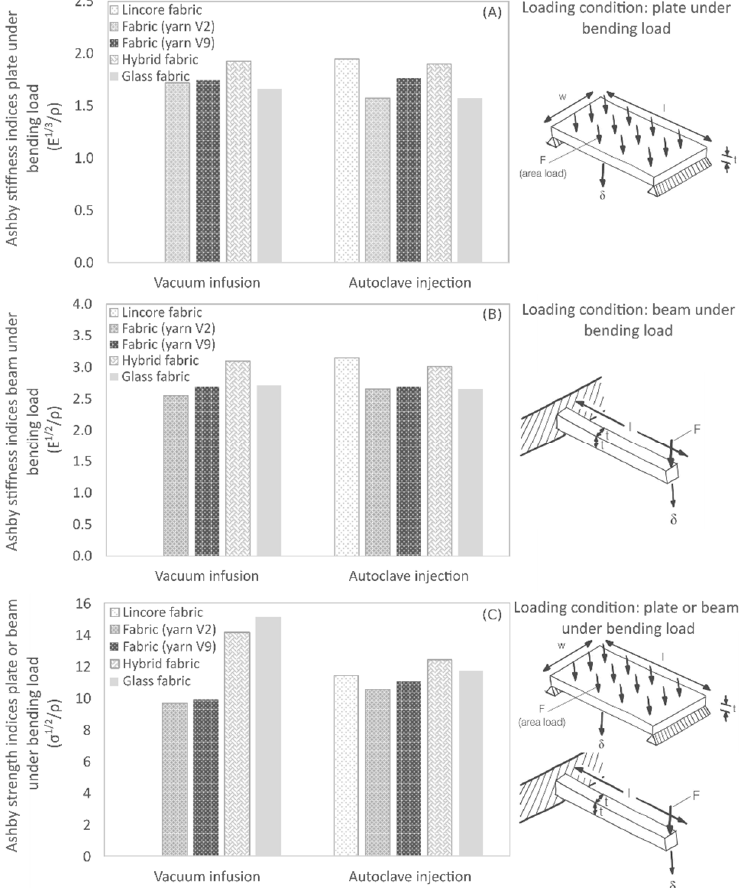
Figure 16. Ashby indices of composite materials produced by vacuum infusion and autoclave injection. The fibre orientation was taken into account in the longitudinal direction. ( A ) plate loaded in bending (stiffness-limited design at minimum mass; stiffness, length, width specified, thickness free), ( B ) beam loaded in bending (stiffness-limited design at minimum mass; stiffness, length, shape specified, section area free) and ( C ) plate loaded in bending (strength-limited design at minimum mass; plate: stiffness, length, width specified, thickness free) or beam loaded in bending (strength limited design at minimum mass; load, length width specified, thickness free).